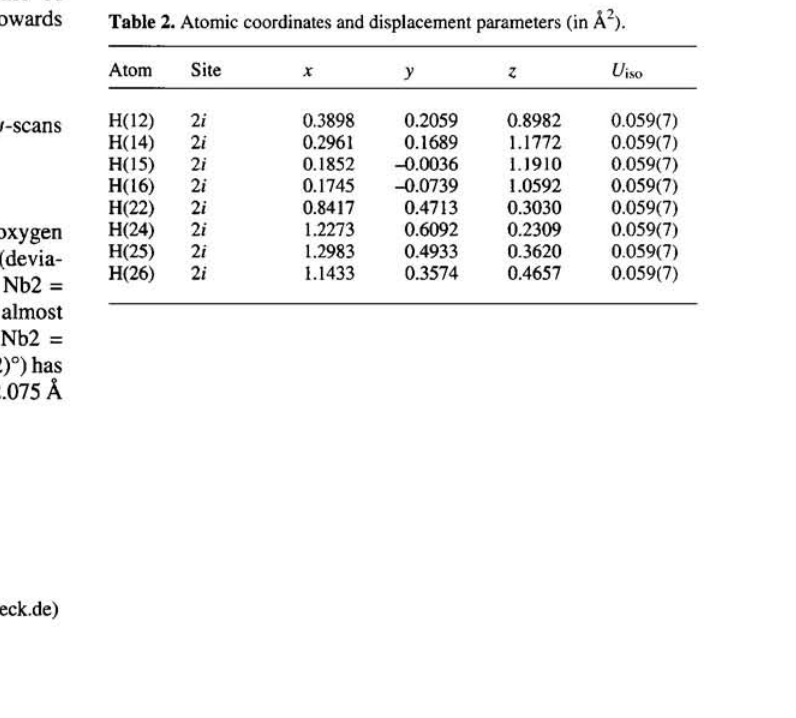
Table 2. Atomic coordinates and displacement parameters (in Ä 2